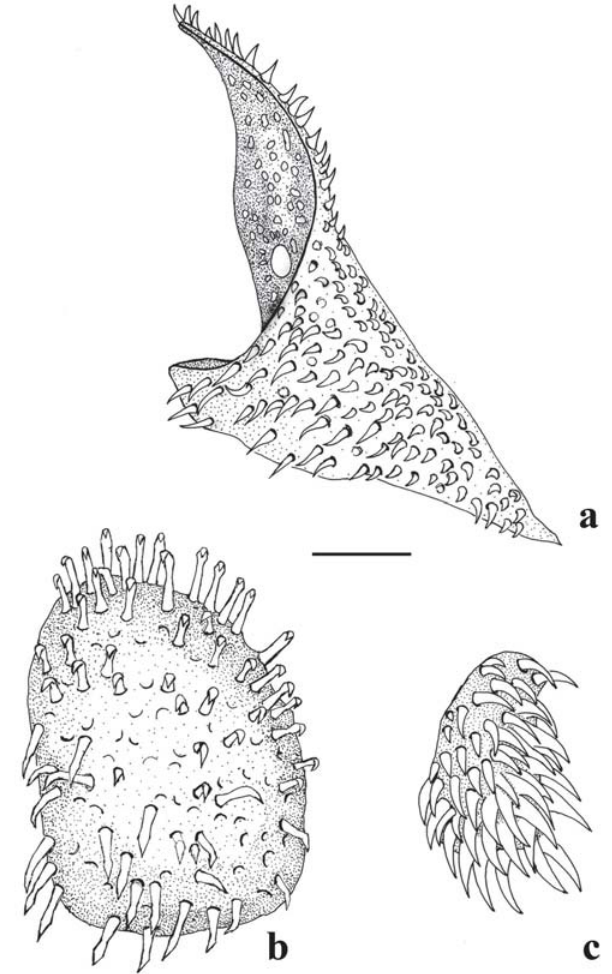
Fig. 28. Ventral view of upper pharyngeal plate (left side) of Lamontichthys filamentosus (LACM 41741-9, 119.4 mm SL) (a), Rineloricaria sp. (MZUSP 23748, 91.5 mm SL) (b) and Neoplecostomus ribeirensis (MZUSP 100920, 45.3 mm SL) (c). Scale bar = 0.5